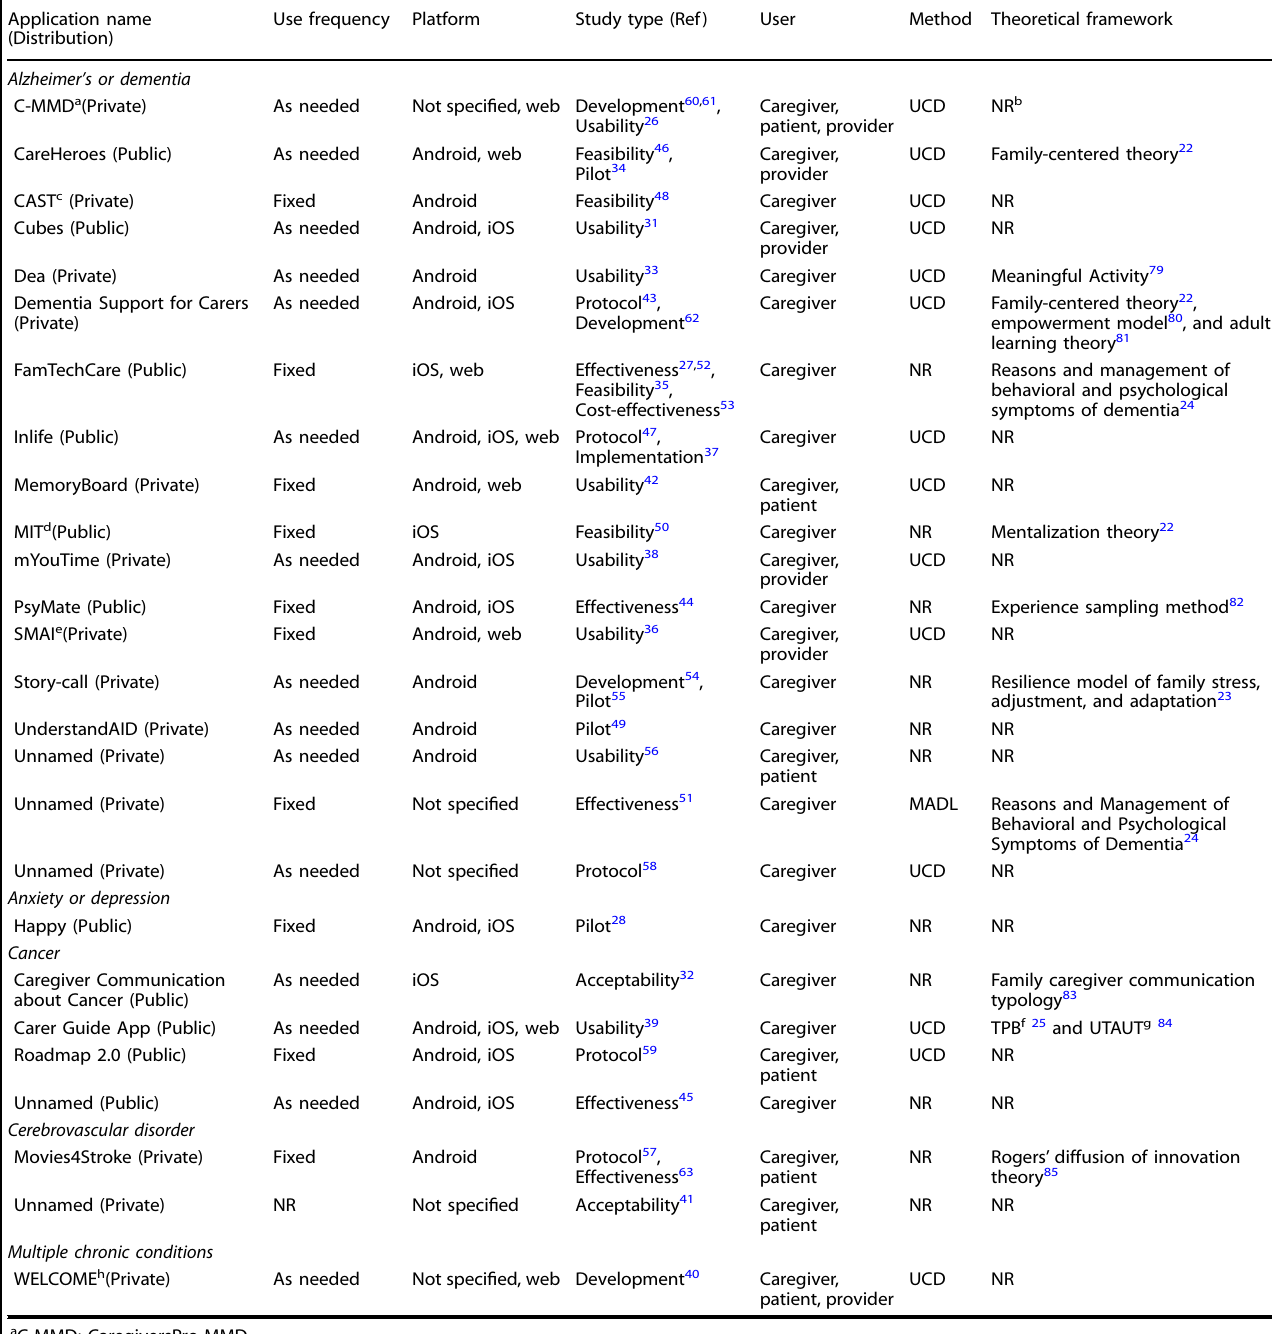
Table 2. Characteristics of native smartphone applications for caregivers grouped by chronic condition